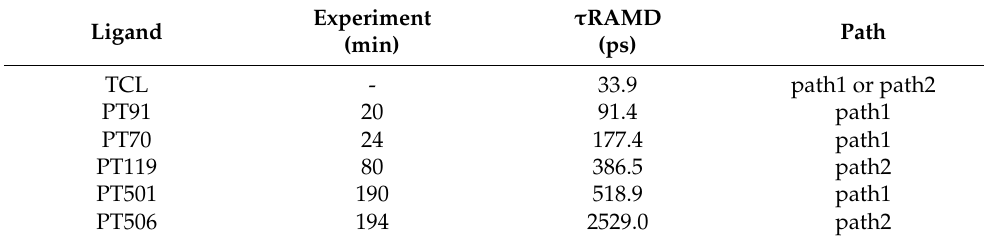
Table 3. Residence time ranking of InhA inhibitors predicted by τ RAMD.